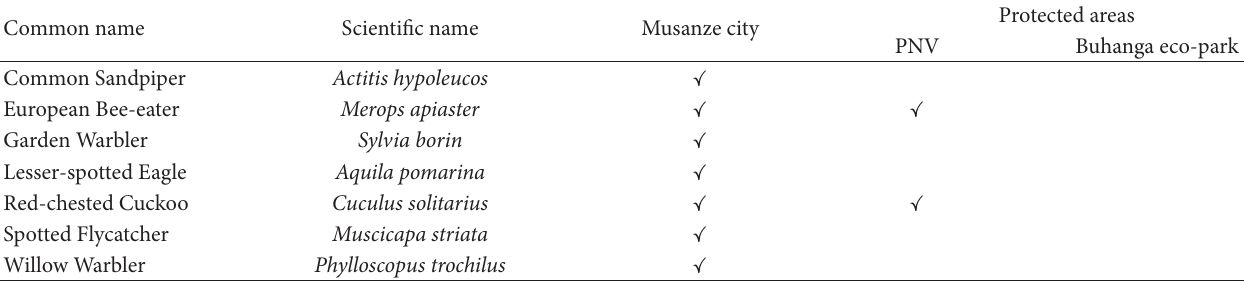
Table 4: Migratory birds in Musanze city, PNV, and Buhanga eco-park.